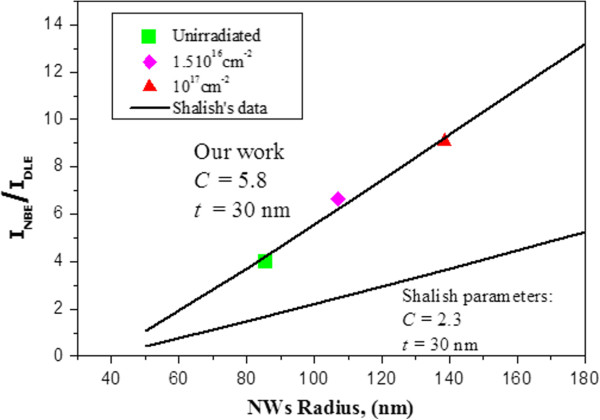
Experimental luminescence peak intensity INBE/IDLE as a function of the average wire radius. Values predicted by Shalish’s data are also included.